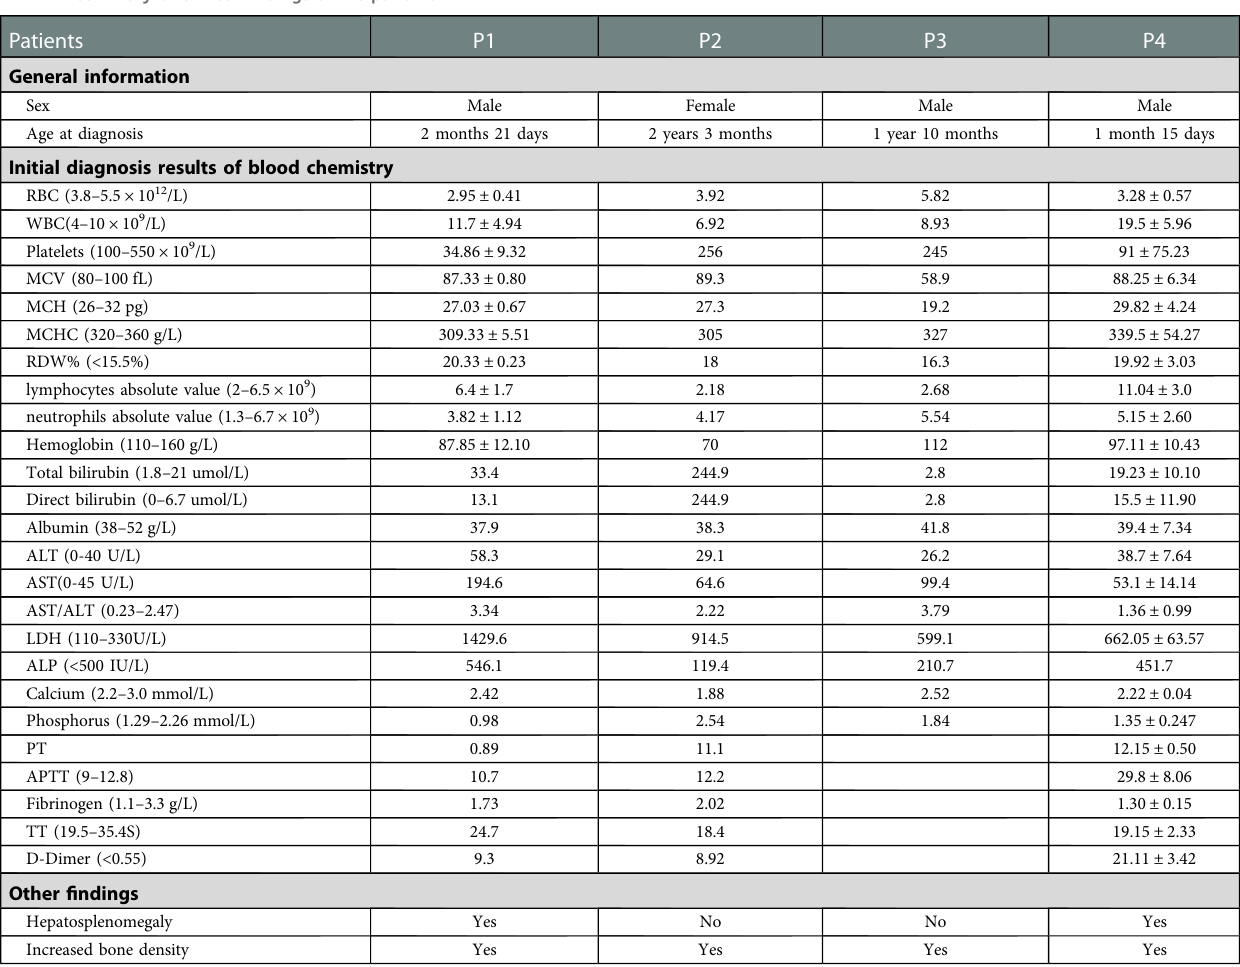
TABLE 1 Summary of clinical fi ndings of the